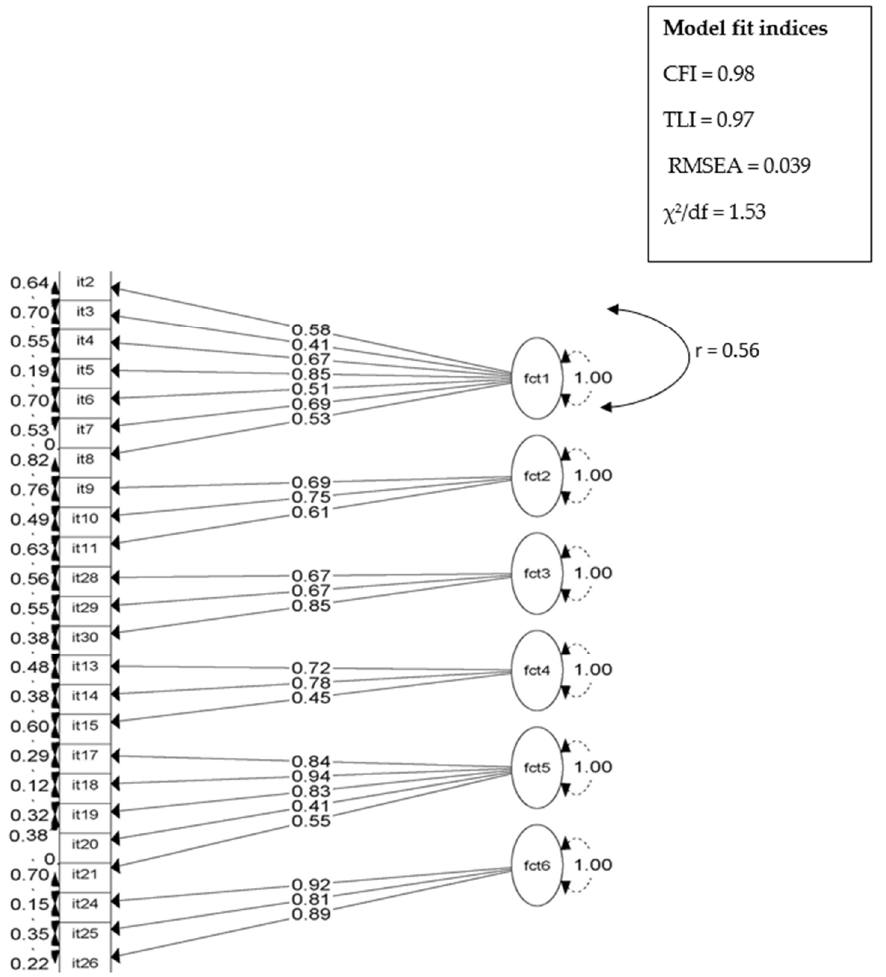
Figure 2. Six-factor model of DWE showing the final confirmatory factor analysis model. ‘It’are variable items included in the final model, 2–8 (Factor 1, Frequency of domestic tasks); 9–11 (Factor 2, Stress appraisal); 13–15 (Factor 3, Demand and control); 17–21 (Factor 4, Water sourcing, and carriage); 24–26 (Factor 5, Experience of water scarcity; 28–30 (Factor 6, Social support). Values to the left of the numbered items are error variances; values within the lines are factor loadings of each observed variable on the latent factors; 1.00 indicates that the variance of each factor was set to 1; r = correlation specified between Factor 5 and 6. Table 2. Final confirmatory factor analysis models and their fit indices .